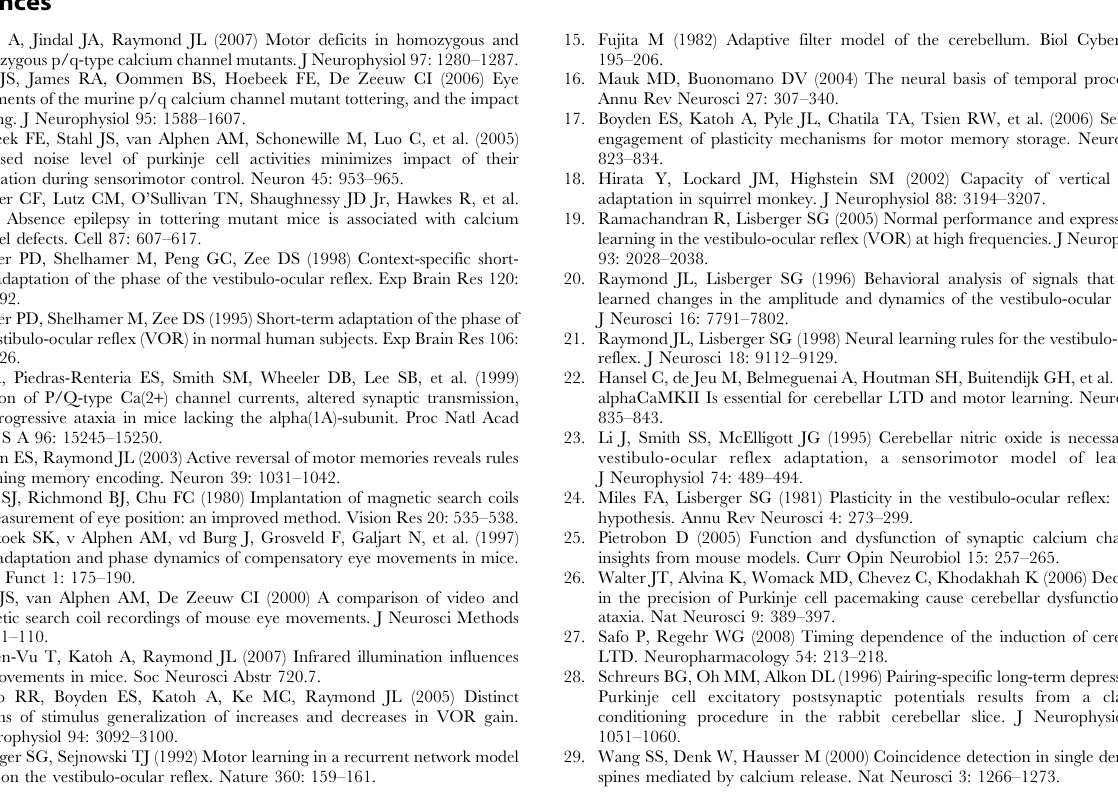
start (top; F 1, 56 =0.011, p . 0.90 for velocity, F 1, 56 =0.461, p . 0.49 for phase) and end (bottom; F 1, 56 =1.29, p . 0.26 for velocity, standard